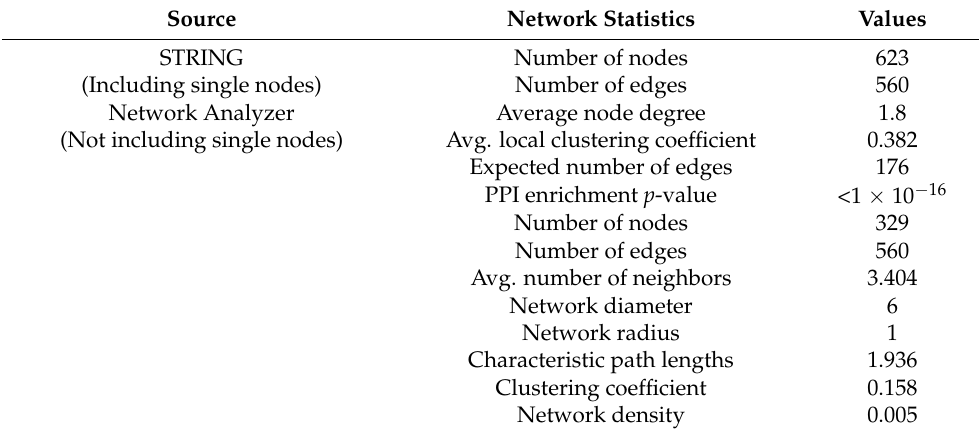
Table 1. Topological parameters of the protein-protein interaction (PPI) network generated in the present study. Source Network Statistics Values STRING Number of nodes 623 (Including single nodes) Number of edges 560 Network Analyzer Average node degree 1.8 (Not including single nodes) Avg. local clustering coefficient 0.382 Expected number of edges 176 PPI enrichment p -value <1 × 10 − 16 Number of nodes 329 Number of edges 560 Avg. number of neighbors 3.404 Network diameter 6 Network radius 1 Characteristic path lengths 1.936 Clustering coefficient 0.158 Network density